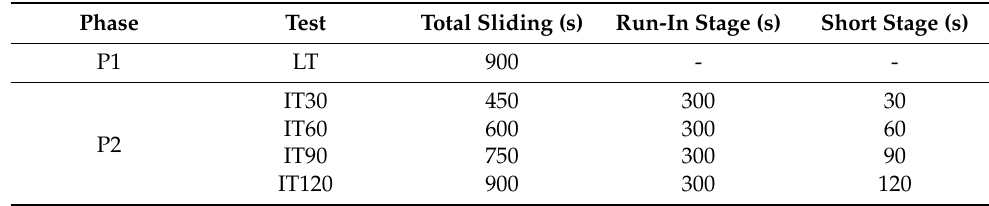
Table 2. Wear test duration